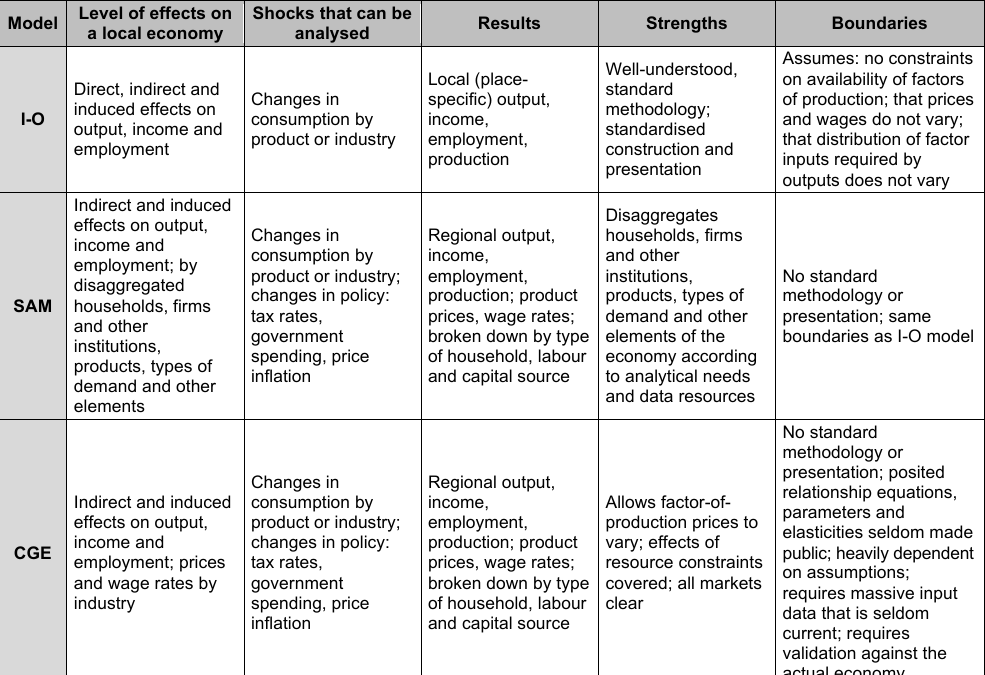
Comparison of characteristics of I-O, SAM and CGE